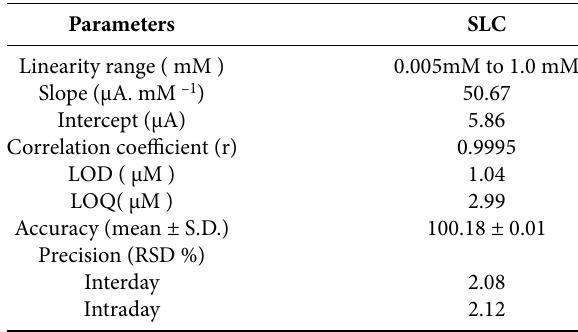
Table 1. The calculated values of αn, α, n, E 0  and k 0 for the elec- tro-oxidation of SLC by cyclic voltammetry (CV) at SMCPE.